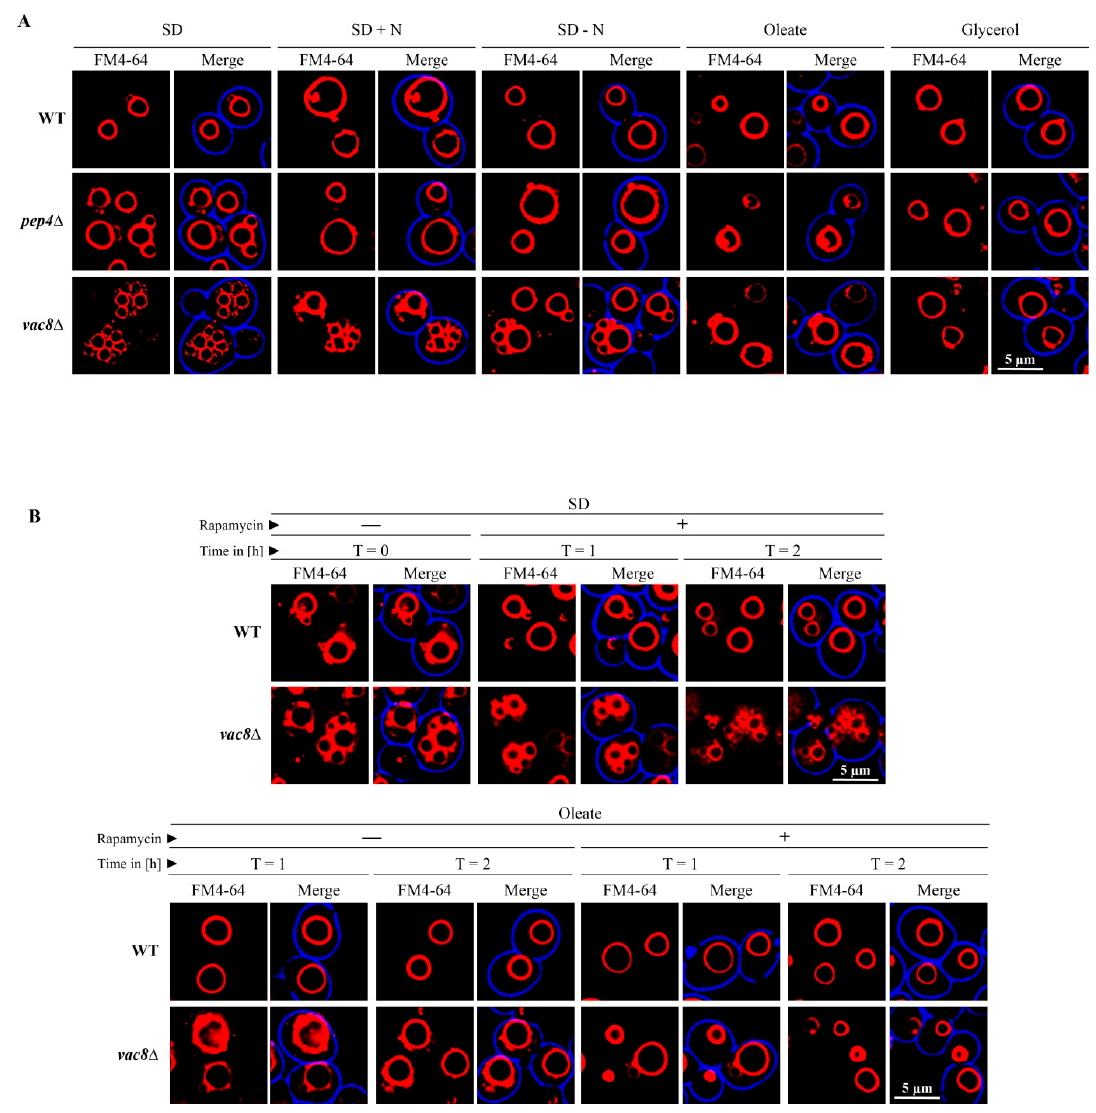
Figure 6. The vacuolar fusion-defect of glucose-grown vac8 Δ cells can be complemented by oleic acid and glycerol. ( A ) Glucose-grown (SD) vac8 Δ cells display the typical fragmented vacuolar phenotype, which is thought to be caused by a vacuolar fusion defect. The shift to SD − N medium leads to the formation of a larger central vacuole associated with some smaller vacuolar structures. The shift of SD grown cells to medium containing oleic acid or glycerol resulted in the formation of vacuoles comparable to WT cells. ( B ) The morphology change of vac8 Δ cells is rapamycin-independent. The morphology of FM4-64-stained vacuoles of cells grown in SD medium is not influenced by the presence of rapamycin under the tested conditions. The presence of rapamycin does not block the morphology shift of vac8 Δ cells from SD medium to oleic acid medium. The small fragmented vacuoles (t = 0 h) fused to large vacuoles (t = 1 h/t = 2 h) with or without rapamycin. 3.7. The Defect of Peroxisome Degradation in vac8 Δ Cells Can Be Complemented by Oleic Acid and Glycerol